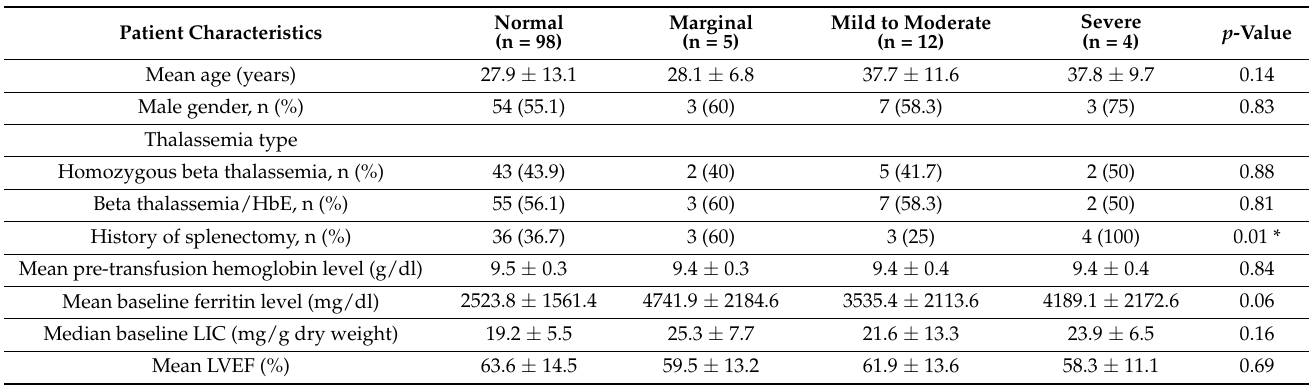
Table 1. Baseline patients characteristics with normal, marginal, mild to moderate, and severe cardiac siderosis.